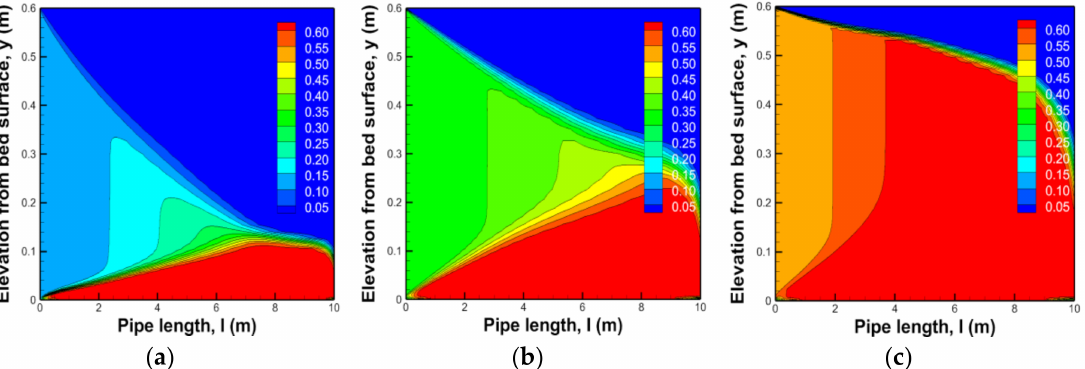
Figure 6. Sedimentation results for soil of diameter 1.0 mm according to changes in volume fraction;